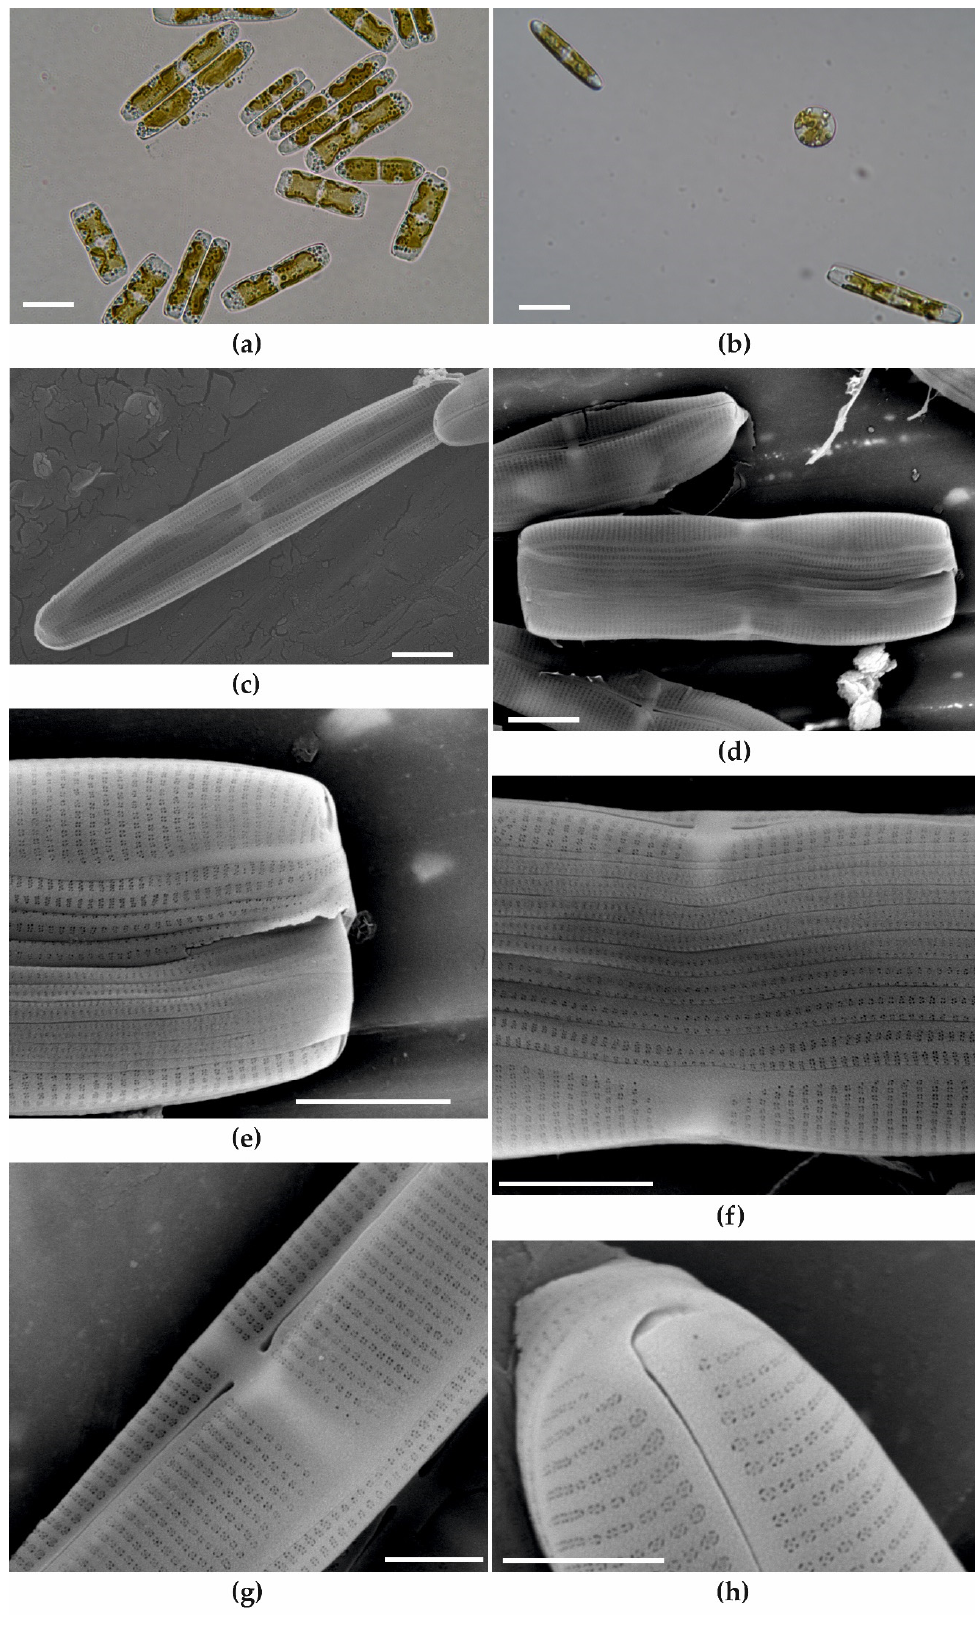
Figure 3. Light ( a , b ) and scanning electron images ( c – h ) of Craspedostauros ineffabilis IMA082A. Scale bars: ( a , b ) = 20 μ m; ( c , d ) = 5 μ m; ( e , f ) = 4 μ m; ( g , h ) = 2 μ m.